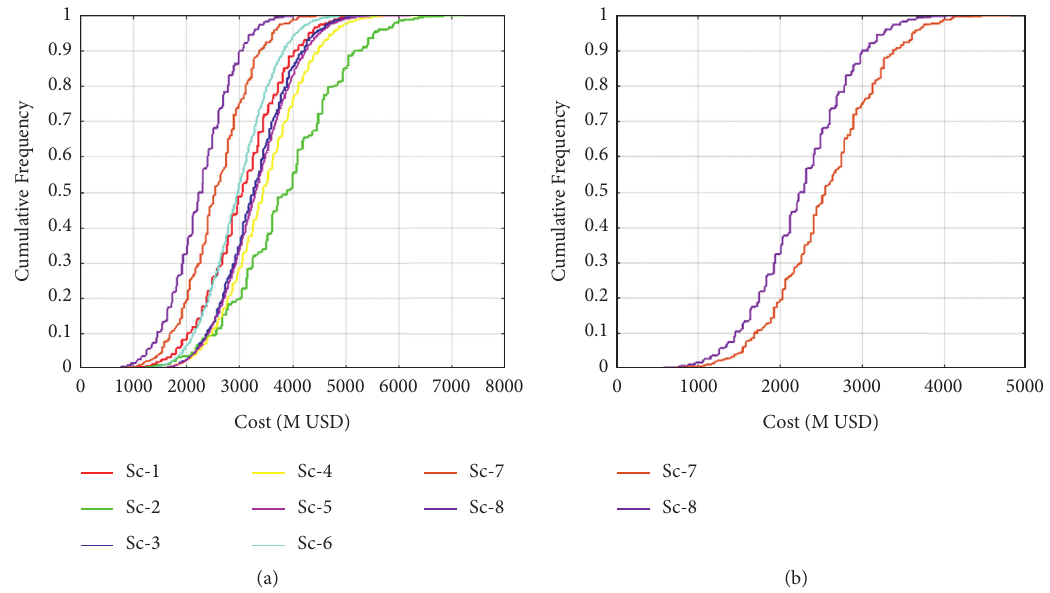
Figure 19: MATLAB simulations of cost versus cumulative frequency (a) for all scenarios and (b) for Sc-7 &